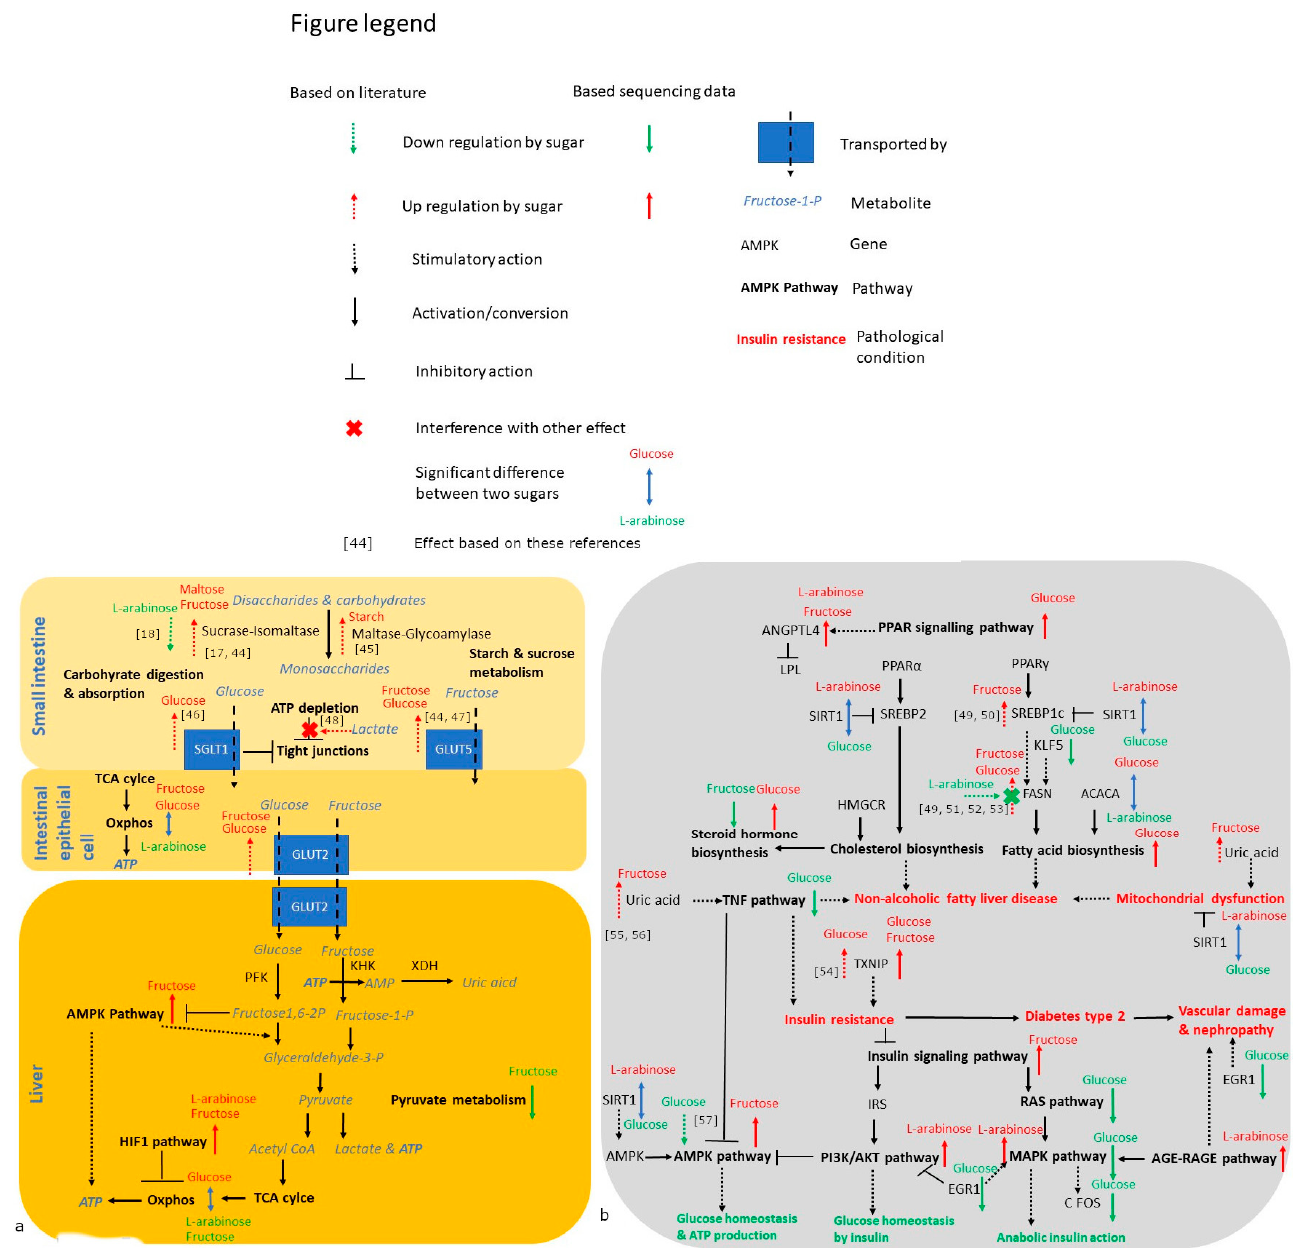
Figure 6. Pathway figure showing how energy metabolism ( a ) and metabolic health ( b ) are affected by 55 mM glucose, fructose and L -arabinose (5 well-replicates spread over 3–5 independent plates per condition). Bold arrows next to a gene or pathway indicate that they are significantly ( p < 0.05 following corrections for multiple comparison) impacted by 24-h sugar exposure: green (downregulation compared to mannitol), red (upregulation compared to mannitol) or blue (significantly higher for the sugar stated above versus below the arrow) [17,18,44–57].